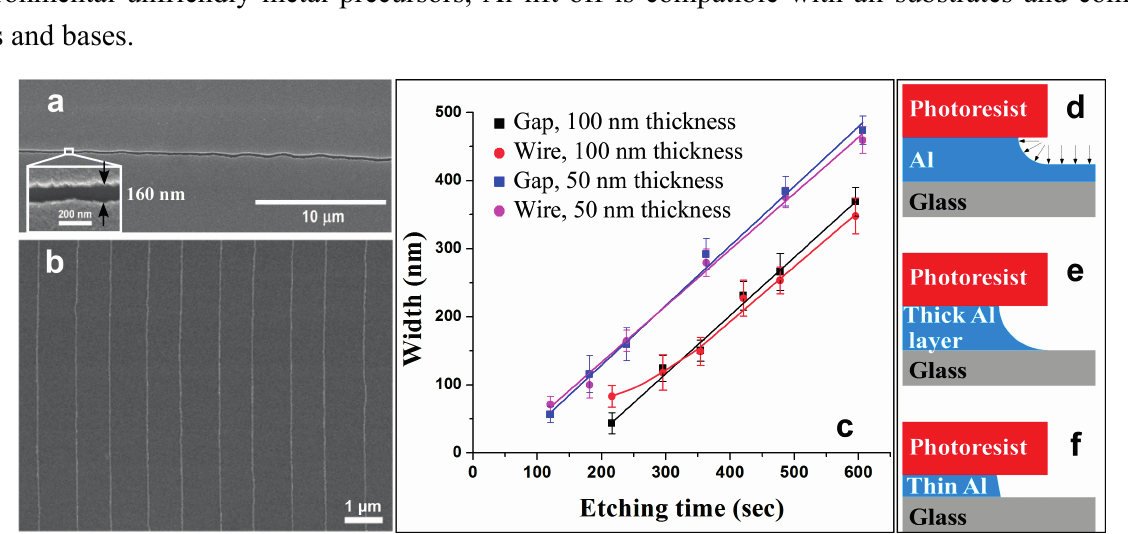
Figure 2. ( a ) SEM images of Al nanogaps formed using the process described in Figure 1a–d; ( b ) Representative Cr nanowires realized by thermal evaporation of chromium onto the Al-nanogaps of ( a ) and Al lift-off (shown in Figure 1e,f); ( c ) Nanogap and nanowire width for two Al thickness layers, as a function of Al etching time. The Al undercut produced by isotropic etching ( d ) works less optimally for thick ( e ); as opposed to thin ( f ) Al layers and small etching